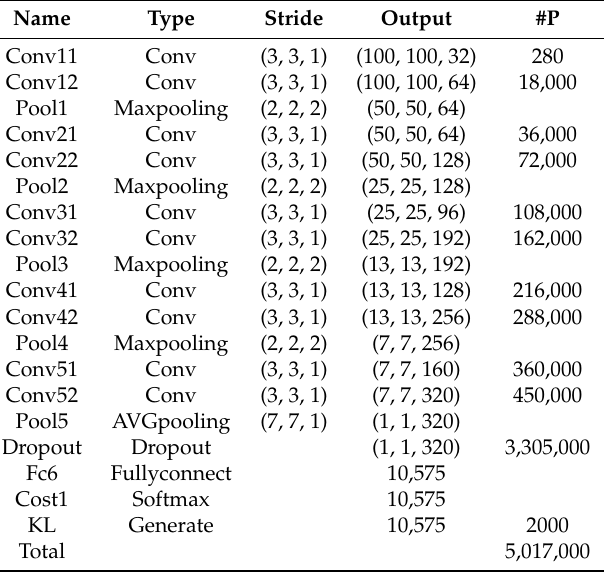
Figure 10. The loss on ETI datasets and WETI datasets with the same network model Table 2. Convolutional neural network (CNN) models and the